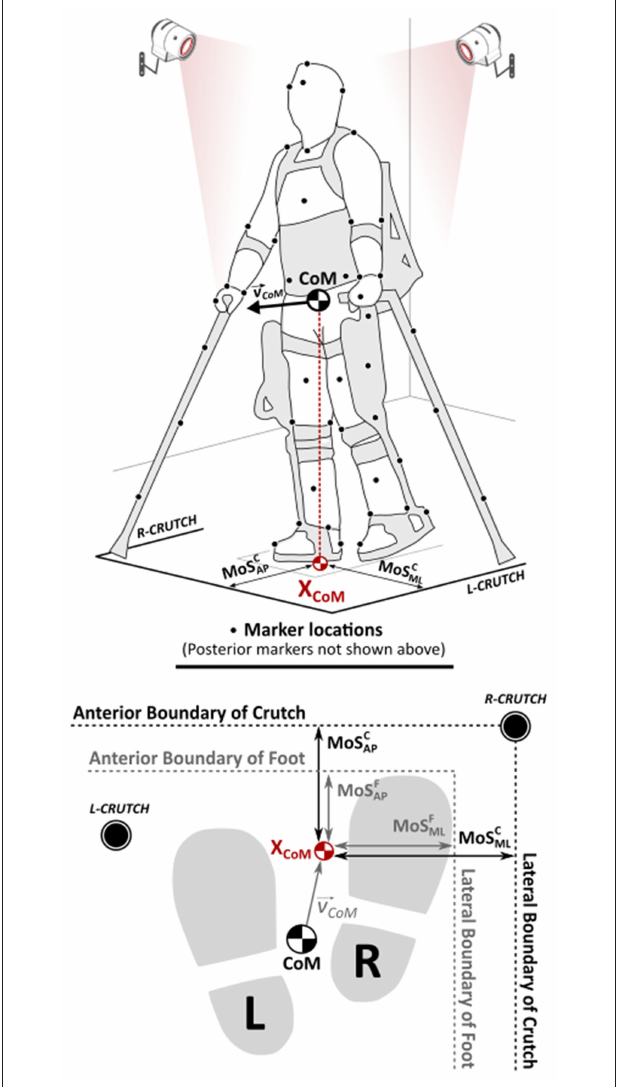
FIGURE 1 | Center of mass (CoM) representation and definitions for the margins of stability (MoSs) with respect to the feet and bilateral crutches.